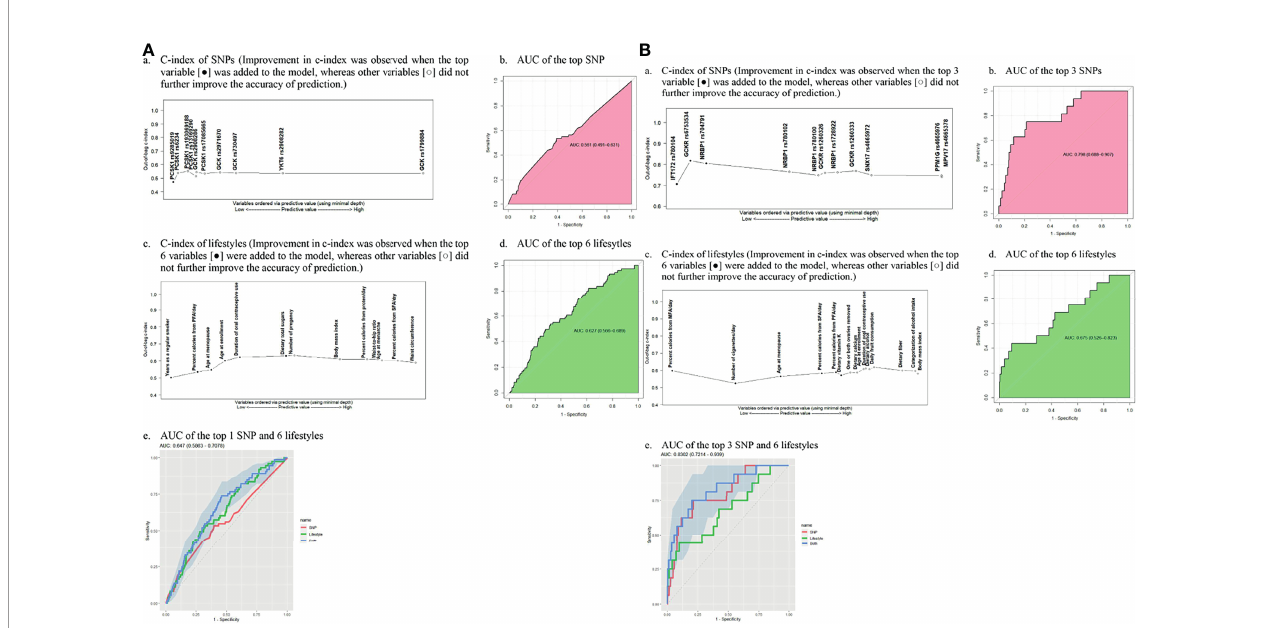
FIGURE 2 | Out-of-bag concordance index (C-index) and area under the receiver operating characteristic curve (AUC) for the topmost genetic and lifestyle factors (MFA, monounsaturated fatty acid; PFA, polyunsaturated fatty acid; SFA, saturated fatty acid SNP; single-nucleotide polymorphism (A) African American women. (a) C-index of SNPs (Improvement in c-index was observed when the top variable [ (cid:129) ] was added to the model, whereas other variables [ ○ ] did not further improve the accuracy of prediction. (b) AUC of the top SNP (c) C-index of lifestyles (Improvement in c-index was observed when the top 6 variables [ (cid:129) ] were added to the model, whereas other variables [ ○ ] did not further improve the accuracy of prediction.) (d) AUC of the top 6 lifesytles (e) AUC of the top 1 SNP and 6 lifestyles (B) . Hispanic American women. (a) C-index of SNPs (Improvement in c-index was observed when the top 3 variable [ (cid:129) ] was added to the model, whereas other variables [ ○ ] did not further improve the accuracy of prediction.) (b) AUC of the top 3 SNPs (c) . C-index of lifestyles (Improvement in c-index was observed when the top 6 variables [ (cid:129) ] were added to the model, whereas other variables [ ○ ] did not further improve the accuracy of prediction.) (d) AUC of the top 6 lifestyles (e) AUC of the top 3 SNP and 6